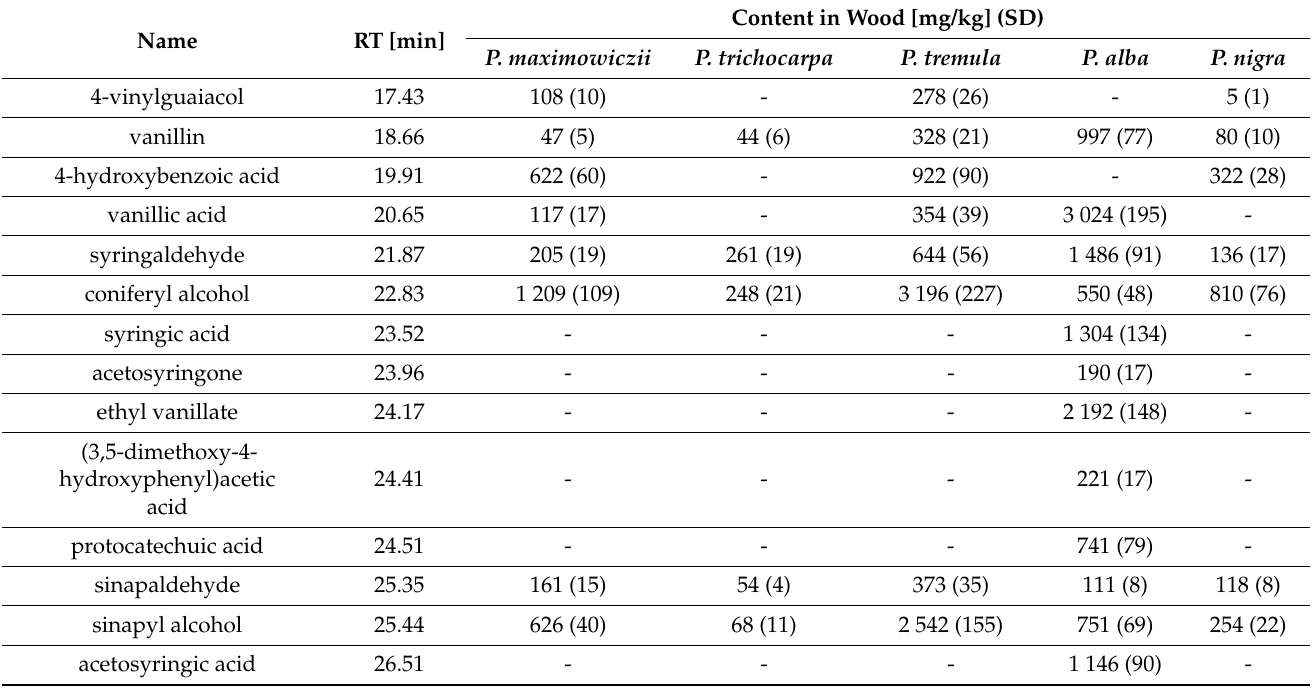
Table 3. Phenolic compounds identified in wood extracts of the studied poplar